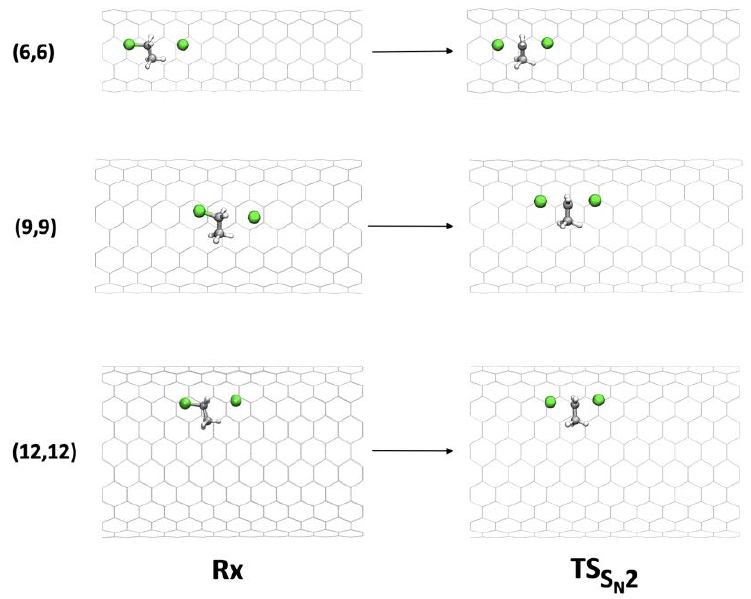
Figure 4. Geometries of Rx and TS of the S N 2 mechanism inside (6,6), (9,9), and (12,12) CNTs. Table 4. Energy contributions (kcal mol −1 ) to the overall confinement effect on the S N 2 reactions.